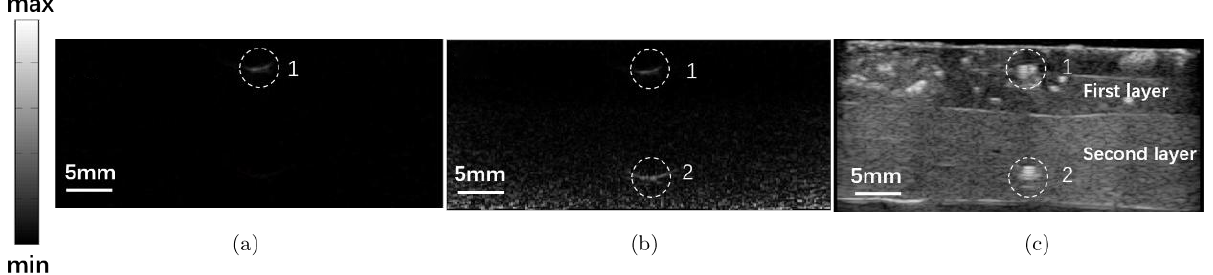
Fig. 4. (a), (b) PA images of phantom with and without optical °uence compensation; (c) US images of the same phantom.